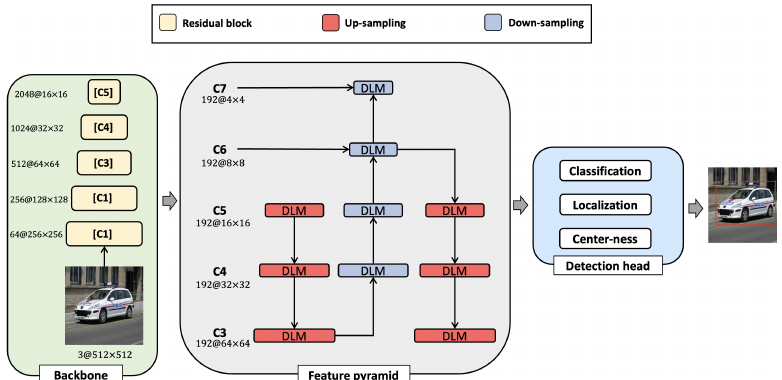
Figure 3. Proposed method architecture. The proposed method used ResNet-50 as the backbone input to the DLM-reconstructed FPN, which is designed to minimize feature map loss. Subsequently, to minimize the overall computational burden, the feature map extracted from the backbone is adjusted to 192 channels using a 1 × 1 convolution. DLM: dual-path lightweight module.